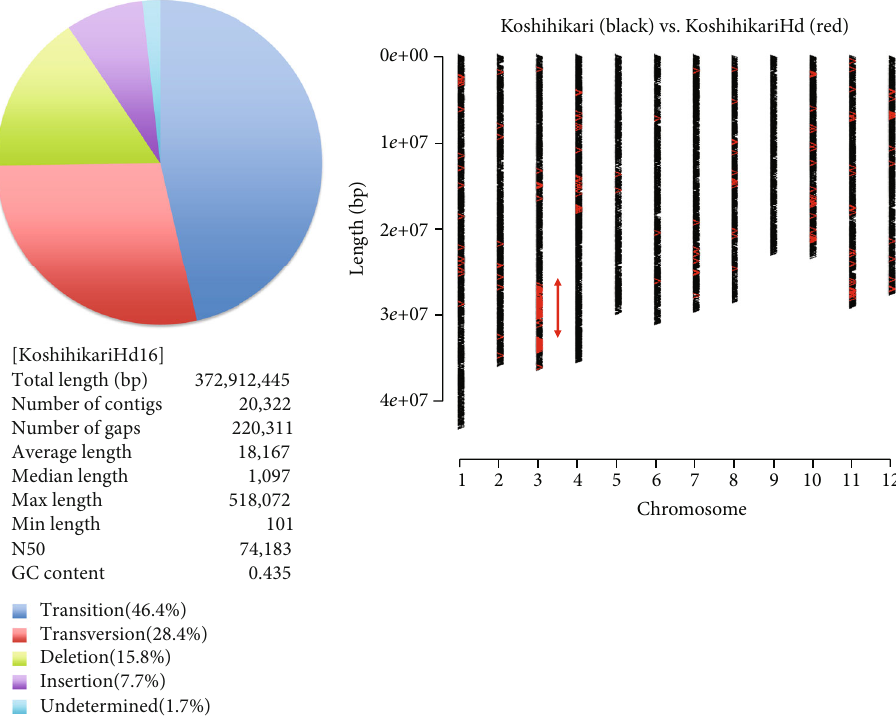
Figure 4: Whole-genome sequencing of late-maturing isogenic Koshihikari (BC sequence was substituted by Koshihikari (black): a large portion of the 12 rice chromosomes were substituted to the DNA sequence derived from Koshihikari (black), except for the block around the 33Mb region in the long arm on chromosome 3 (red arrow) after continuous backcross targeting late-maturing gene. Namely, SNPs derived from Isehikari were concentrated and remained around the 33Mb region of chromosome 3, which also showed a linkage relation with SSR markers (Figure 1). Polymorphisms among [Koshihikari Hd16] and [Koshihikari] contained 46 : 4 + 28 : 4 + 1 : 7 = 76 : 5 % SNPs and 23.5%